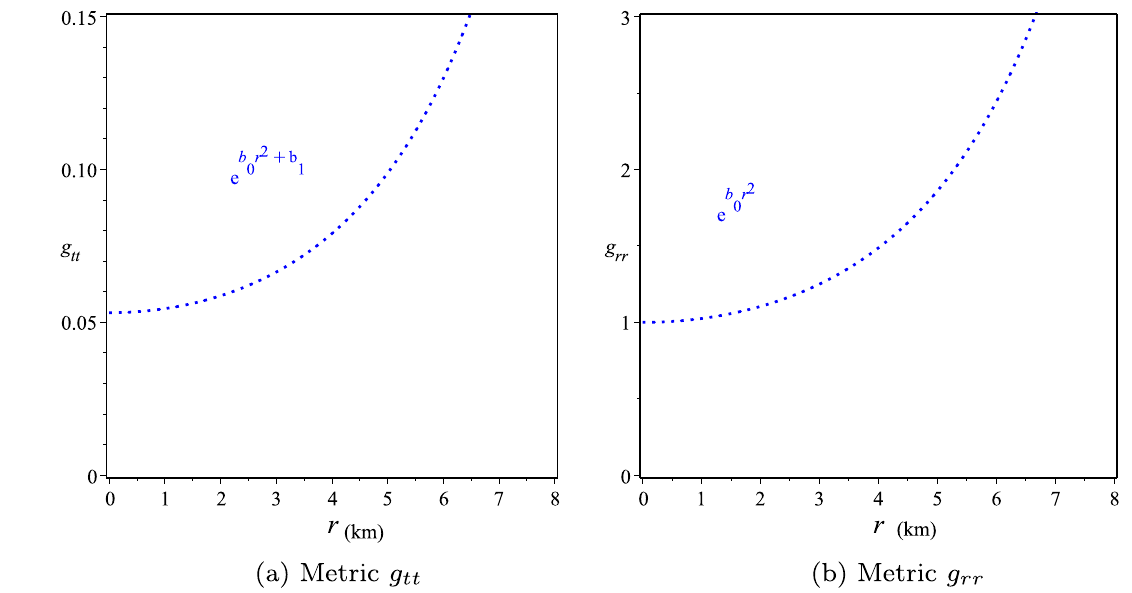
Fig. 1 Schematic plot of the radial coordinate r in Km versus the potentials of the metric (11) using the constants constrained from RX J 1856–37 from where we put b 0 = 0 . 0259974 and b 1 = − 3 . 7654625. These values of the two constants b 0 and b 1 will be use throughout this study